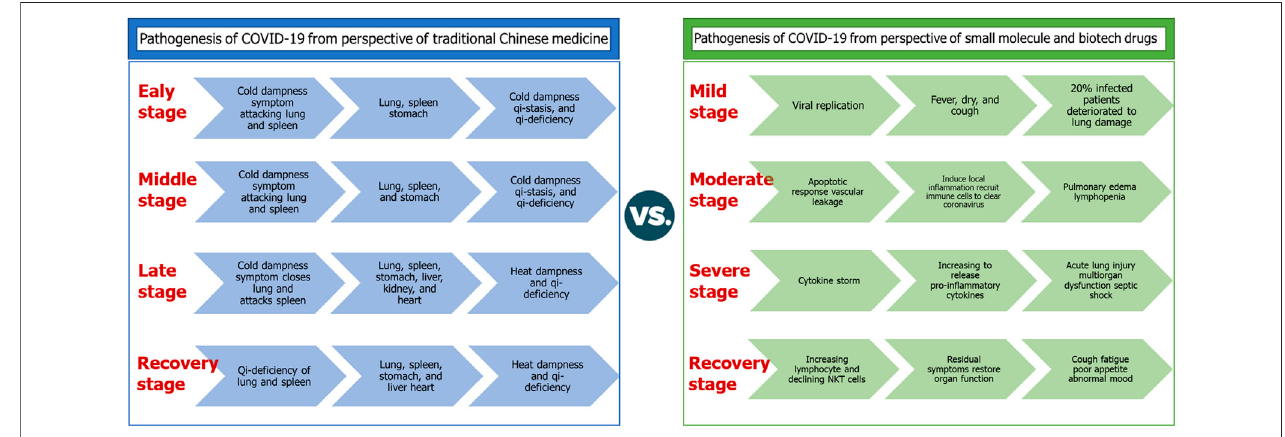
FIGURE 1 | Compared pathogenesis of COVID-19 from herbal medicines and small-molecule